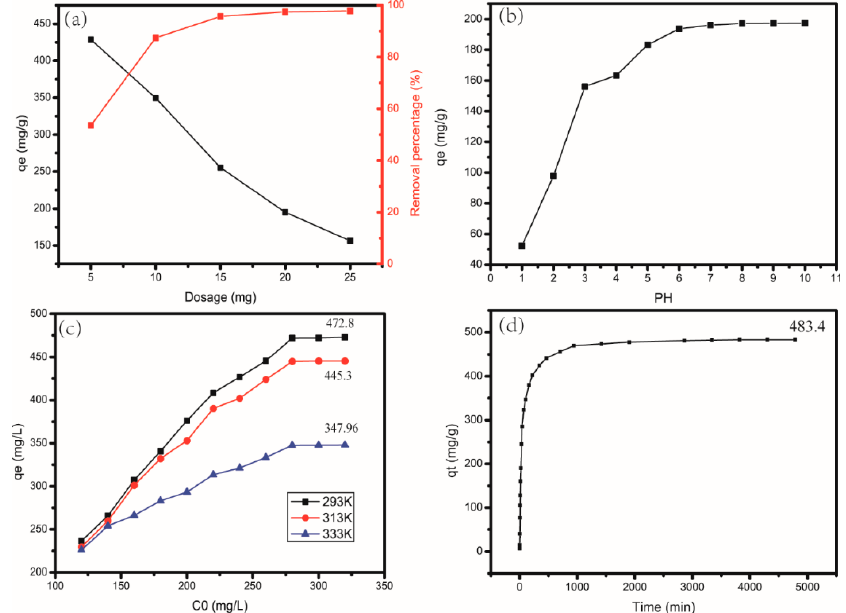
Figure 8. E ff ect of ( a ) dosage at room temperature (20 ◦ C), MB solution: 20 mL, 200 mg / L, ( b ) pH Figure 8. Effect of ( a ) dosage at room temperature (20 °C), MB solution:20 mL, 200 mg/L,.( b ) pH 1–10, 1–10, MB solution: 20 mL, 100 mg / L, room temperature (20 ◦ C), ( c ) temperature, MB solution: 20 mL, MB solution: 20 mL, 100 mg/L, room temperature (20 °C), ( c ) temperature, MB solution: 20 mL, 120– 120–320 mg / L, ( d ) time, amount of CAG: 150 mg, MB solution: 300 mL, 300 mg / L, room temperature (20 ◦ C) on